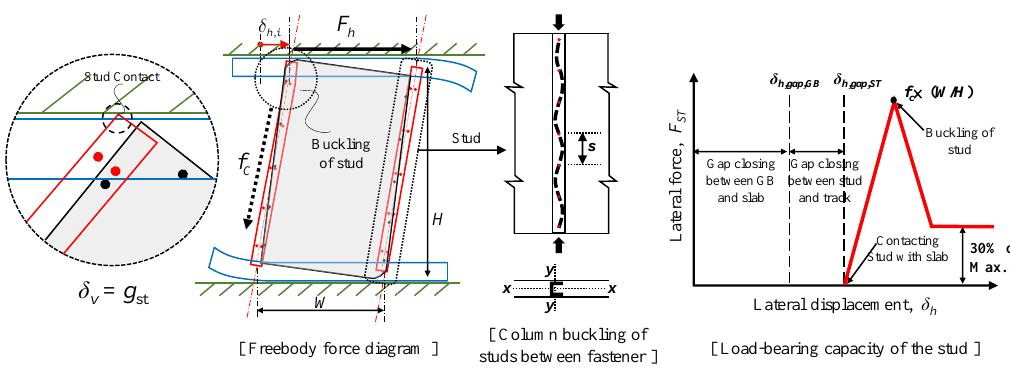
Figure 5. Determination of monotonic behavior of the stud.